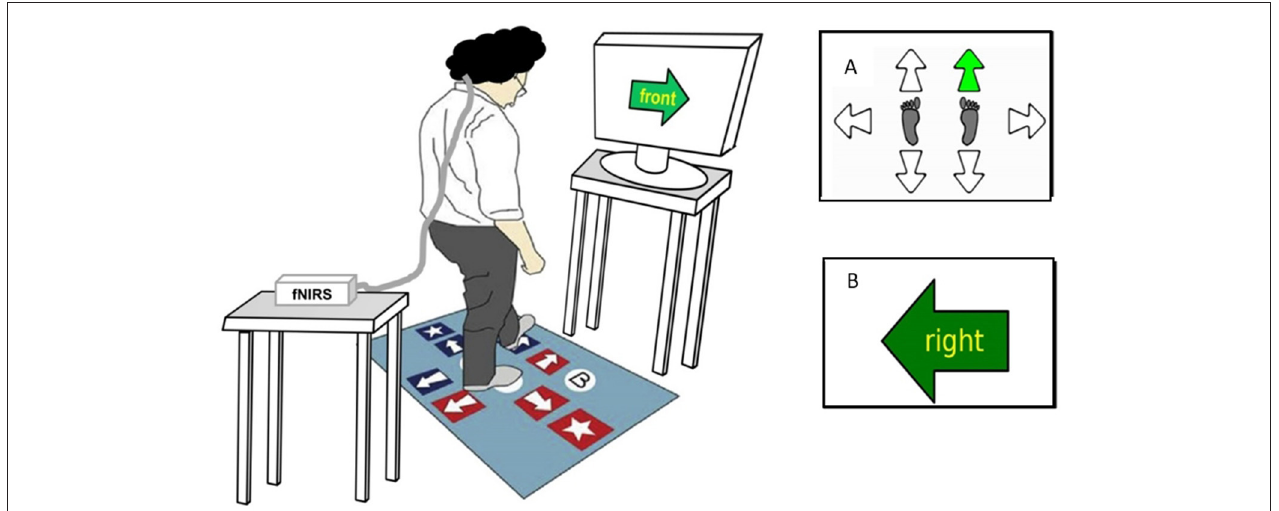
FIGURE 1 | Computerized stepping mat setup and stepping tests display. This figure represents a participant performing the Stroop Stepping Test (SST). The participant stands on the step mat while wearing the fNIRS system on their head with an opaque black cap covering the optodes in order to eliminate the influence of external lights on cortical activity and looks at the monitor screen 1m ahead. Test conditions include the following: (A) Choice-Stepping Reaction Time (CSRT) test, during which participants are required to step as quickly as possible onto the stepping mat panels corresponding to the location of the green arrow appearing (here, right/forward arrow on the mat); and (B) SST, during which participants are required to step as quickly as possible on the panel corresponding to the direction defined by the word in the arrow and not the orientation of the arrow itself (here, step on the right panel).